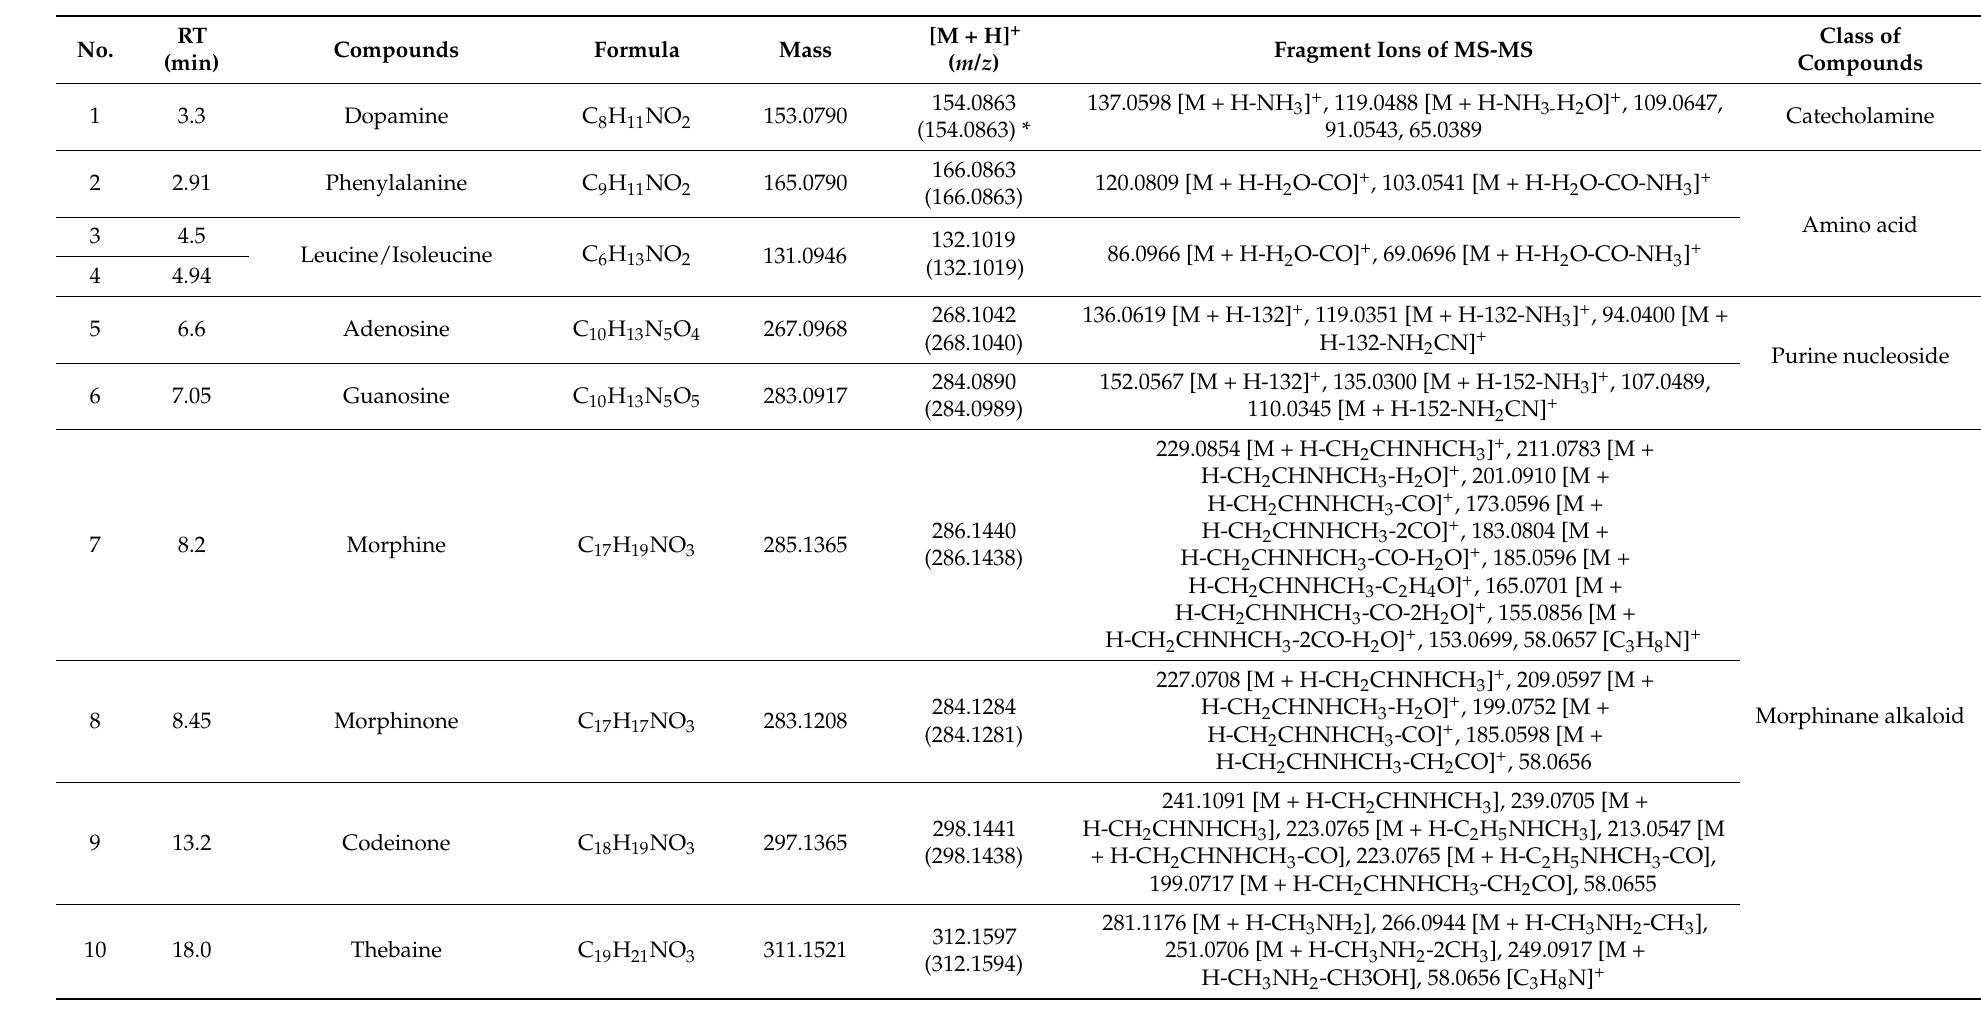
Table 4. RT, compound name, molecular formula, mass, m/z, and major fragment ions for reference compounds and other individual compounds detected in poppy seed samples using